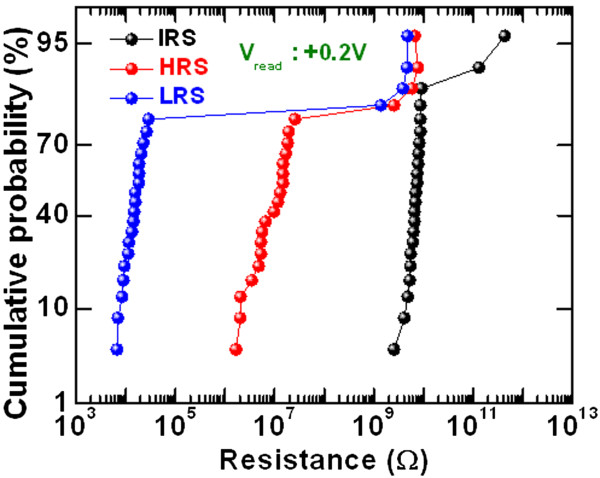
Statistical distribution of resistances. Statistical distribution of IRS, HRS, and LRS of the IrOx/GdOx/W cross-point memory device.